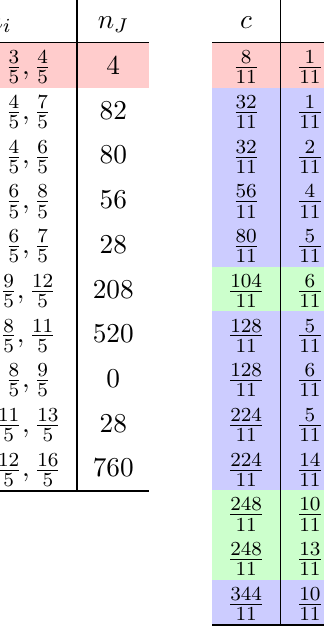
Table 7 . List of all potential ( d, ‘ ) = (5 , 0) theories. Rows colored red denote theories which admit multiple vacuum interpretations. Here we have chosen a single possible interpretation, and n the number of spin-1 currents in that interpretation. Rows colored green (blue) denote cases with a positive (negative) integer Verlinde